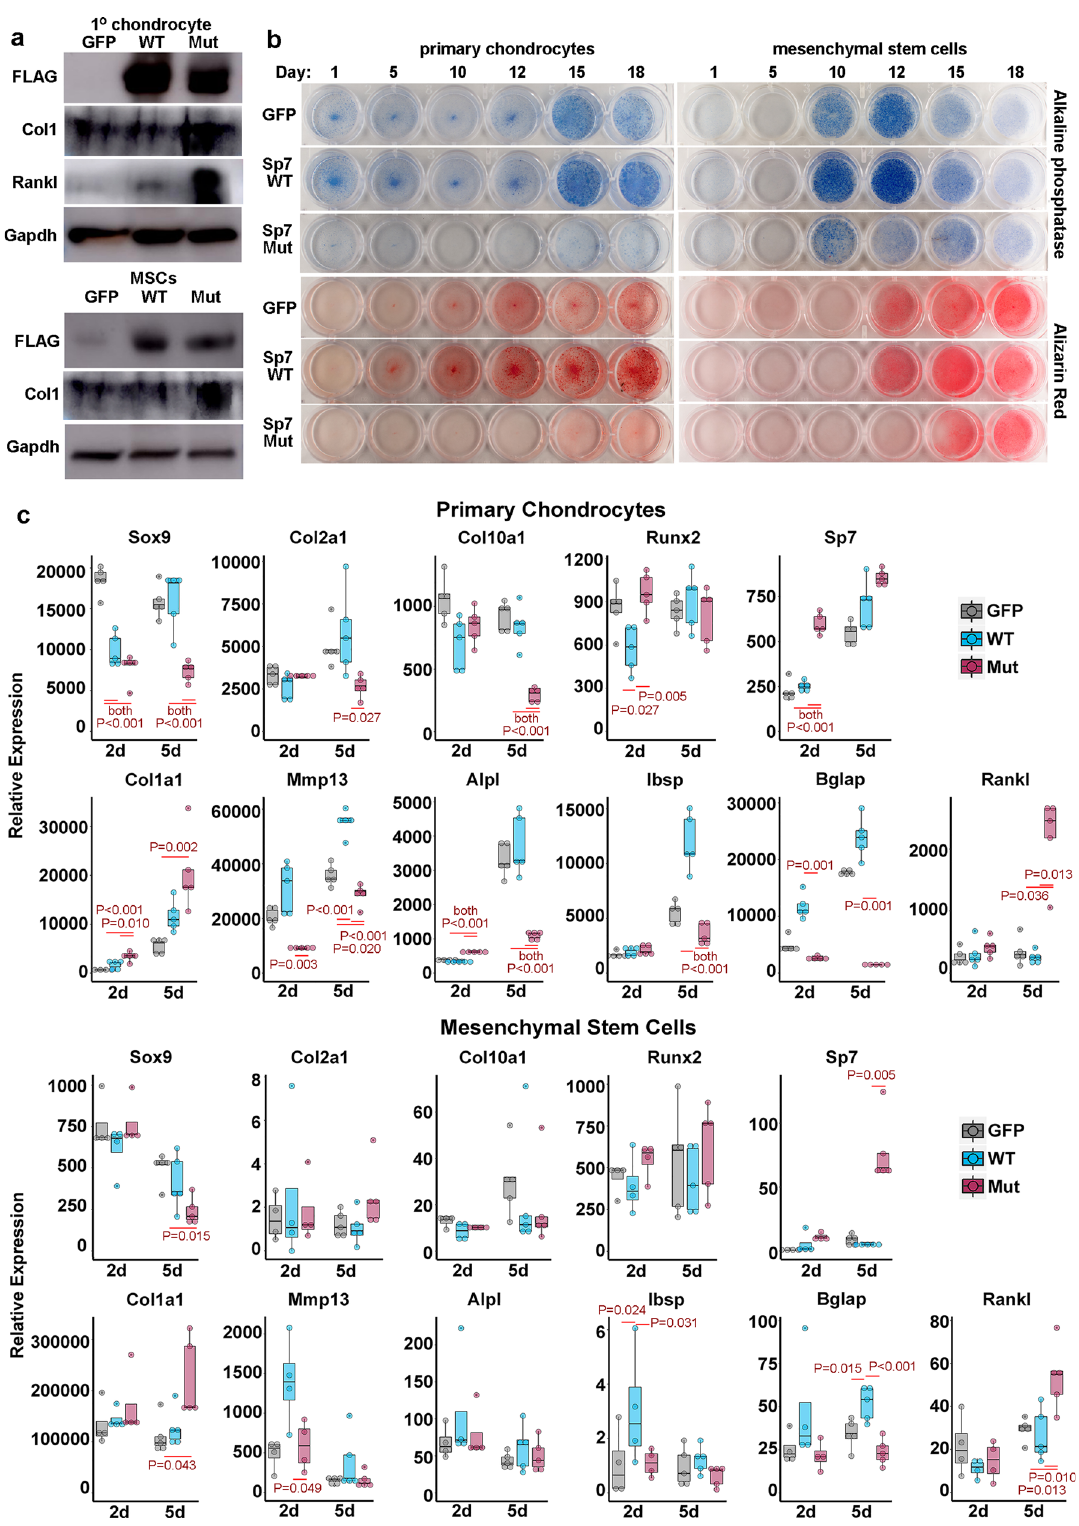
Fig. 3 S309W SP7 variant affected osteoblastic differentiation in vitro. a Retroviral expression of wild-type mutant SP7 produced similar protein levels (by detecting FLAG using Western blot) in primary chondrocytes and mesenchymal stem cells (MSCs), but cells transfected with mutant SP7 showed increased Col1 expression and Rankl expression (for chondrocytes) Experiment was repeated independently 3 times with similar results. b SP7 variant (versus GFP or wild-type) suppressed normal osteoblast differentiation of primary chondrocytes and MSCs, assessed by alkaline phosphatase and Alizarin red staining. c Real-time qPCR showed that infection of mutant SP7 differentially affected expression of genes for osteoblast differentiation or matrix mineralization, shown in box and whisker plots (Rstudio) * P < 0.05, ANOVA ( n = 5), raw values were included in Source data fi le. Bold line inside the box represents the median; upper and lower boundary of the boxes represents the 25th and 75th percentile; whiskers represent the 5th and 9th percentile.